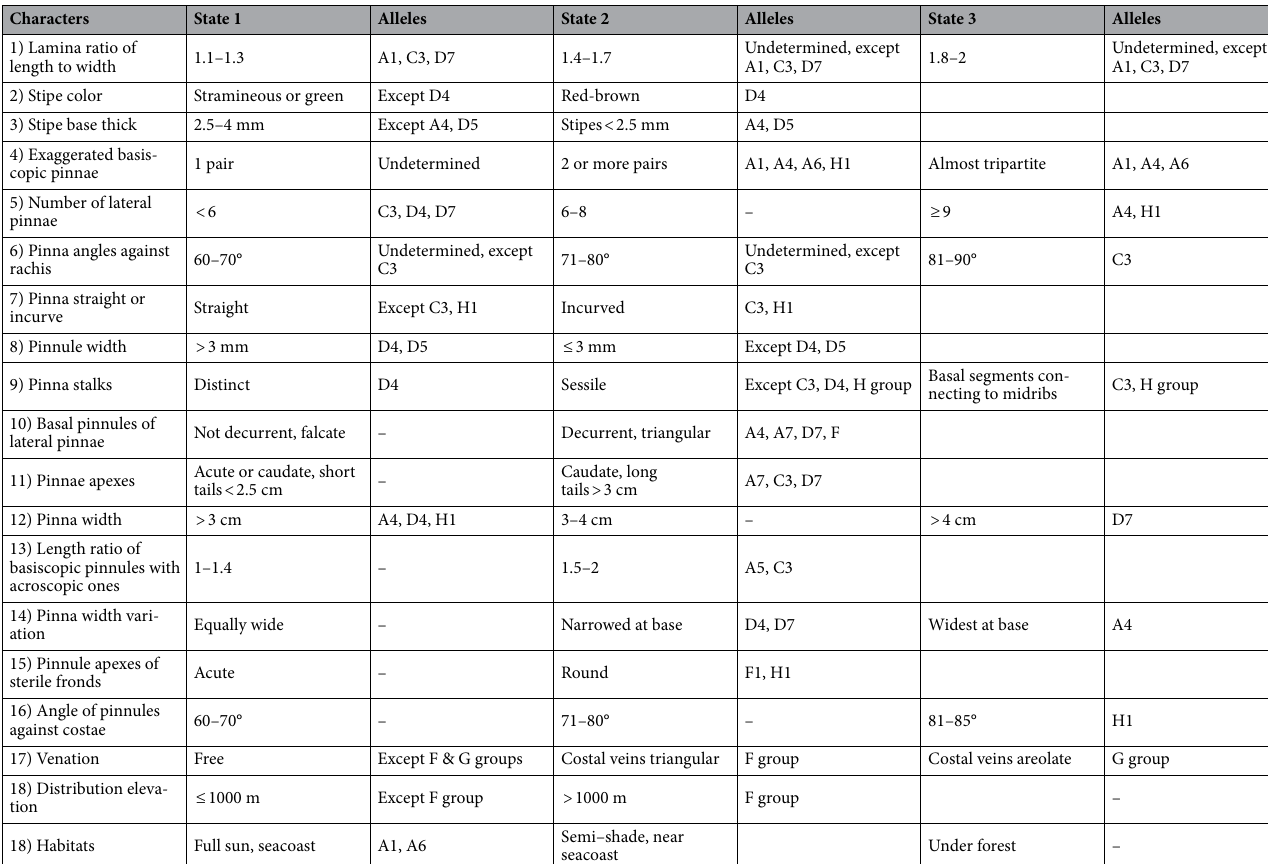
Table 3. The genetic lineage inferences of morphological and habitat characters 51 , based on the Knox 3 gene marker (Table 1) of Pteris fauriei group. The taxa of Pteris fauriei group exhibit the morphology corresponded to their own genotypes. The alleles corresponding to the character state are difficult to